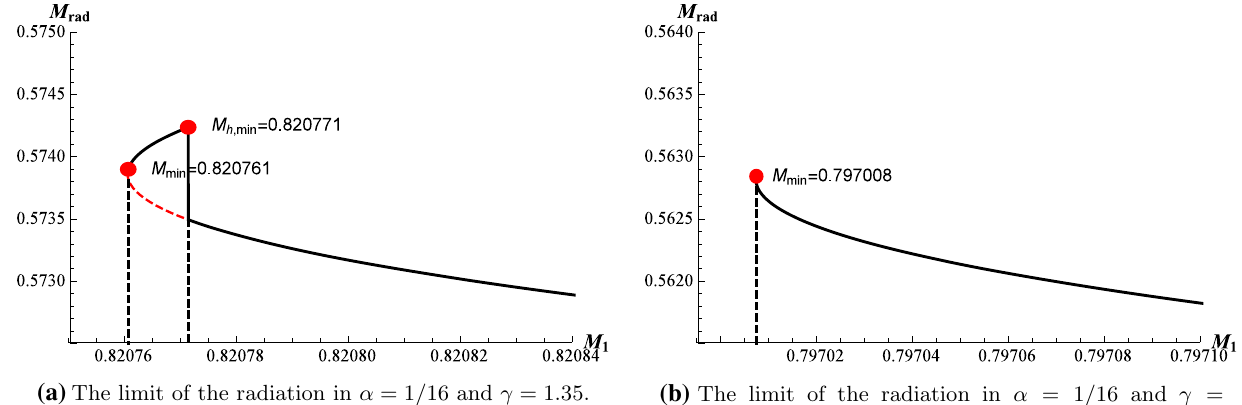
( a ) The limit of the radiation in α = 1 / 16 and γ = 1 . 35. (b) The limit of the radiation in α = 1 / 16 and γ = 1 . 29859. Fig. 4 The upper limits of the collision of two dilatonic black hole for different values of